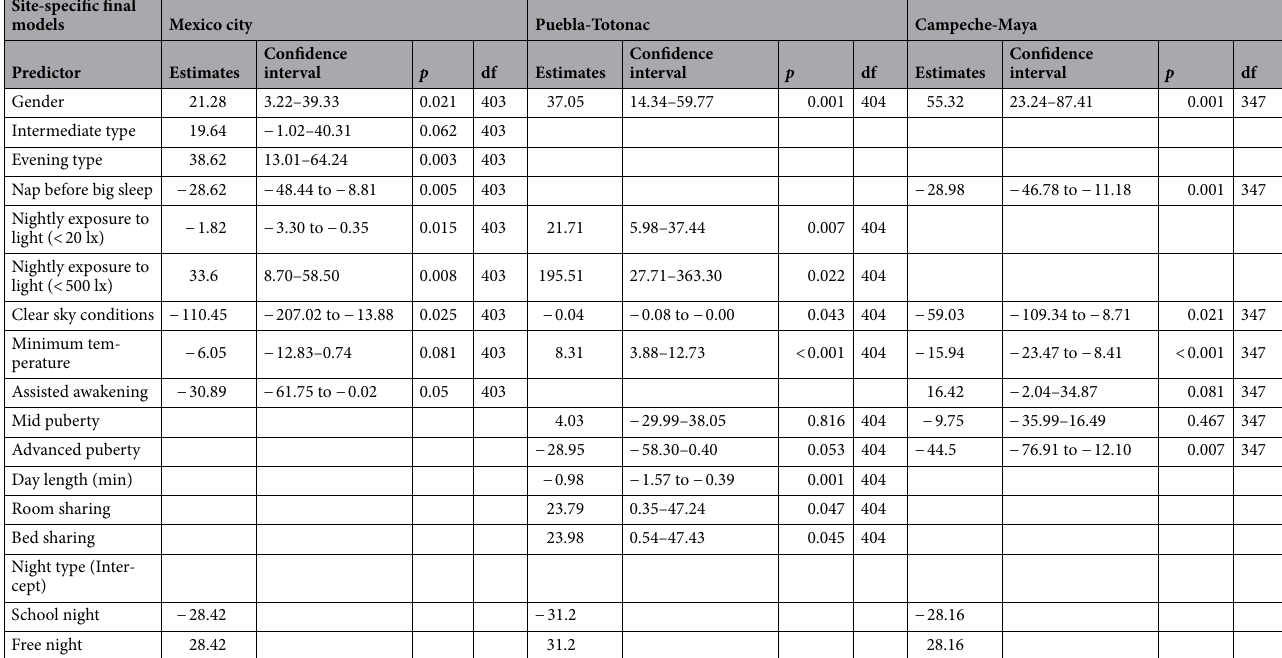
Table 6. Bio-socio-cultural predictors of sleep duration values for each study location across weeknights. † Boys are the reference category for gender; the estimates are for